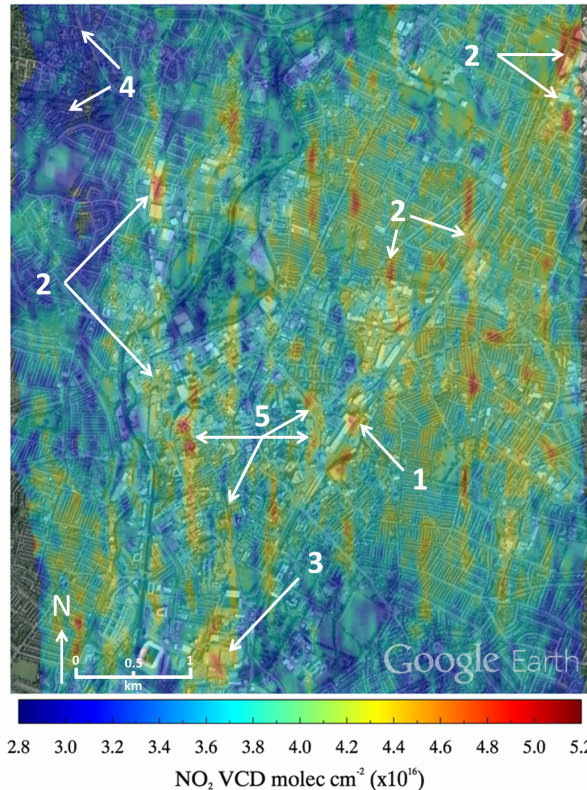
Figure 11. NO 2 VCD data recorded over Leicester City centre over- laid on Google Earth with areas of interest highlighted. Regions of interest labelled in the diagram are the train station (1), industrial areas (2), car parks (3), farmland (4) and highly emitting roads and junctions